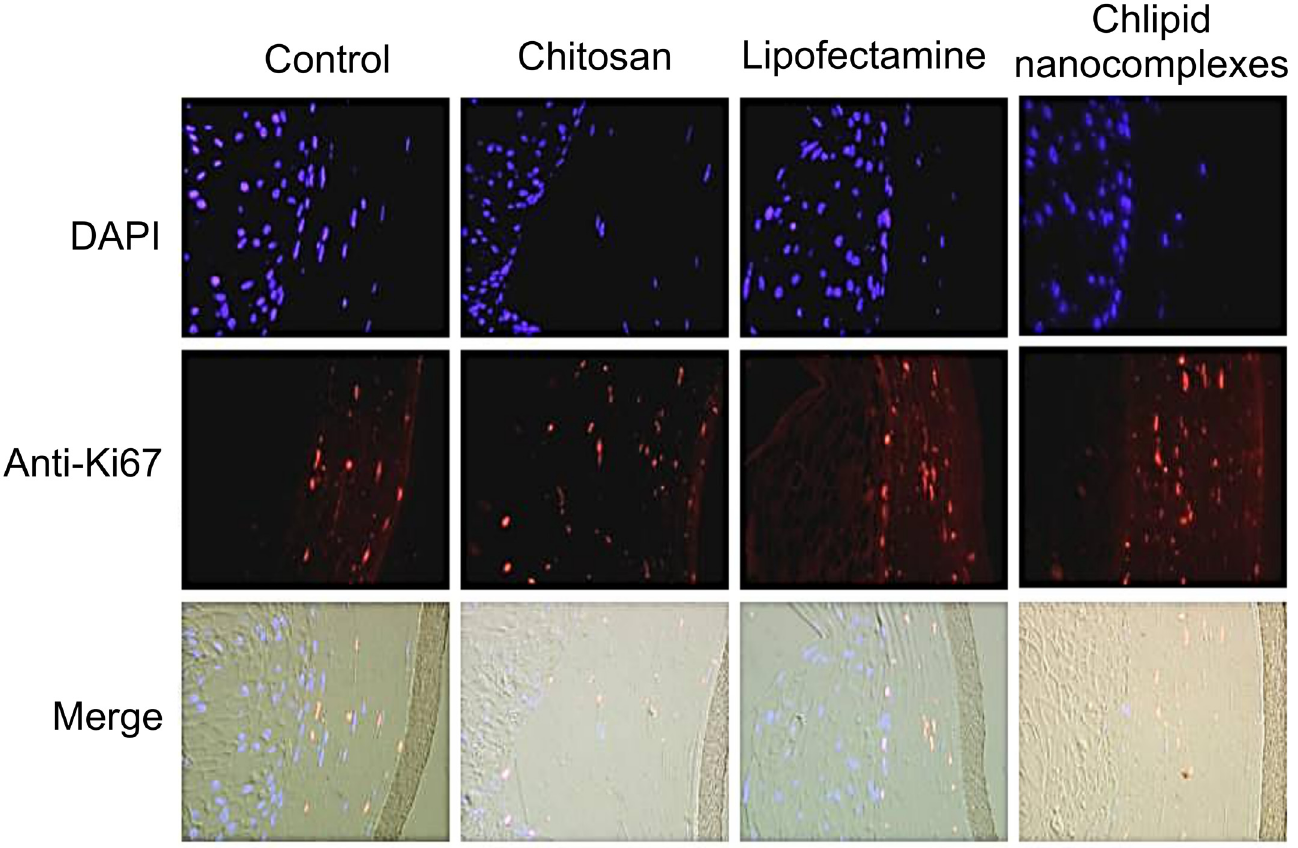
Fig 4. Effects of CNs on the cell proliferation of the 3-D VEC model. Cells in the 3D-VEC model were transfected with either chitosan or Lipofectamine 2000 or chlipid nanocomplexes. At 48 h post-administration, the tissues were fixed in 10% formalin and paraffin embedded. Sections were immunostained using anti-Ki67antibody tagged with Alexa Fluor 555 and DAPI